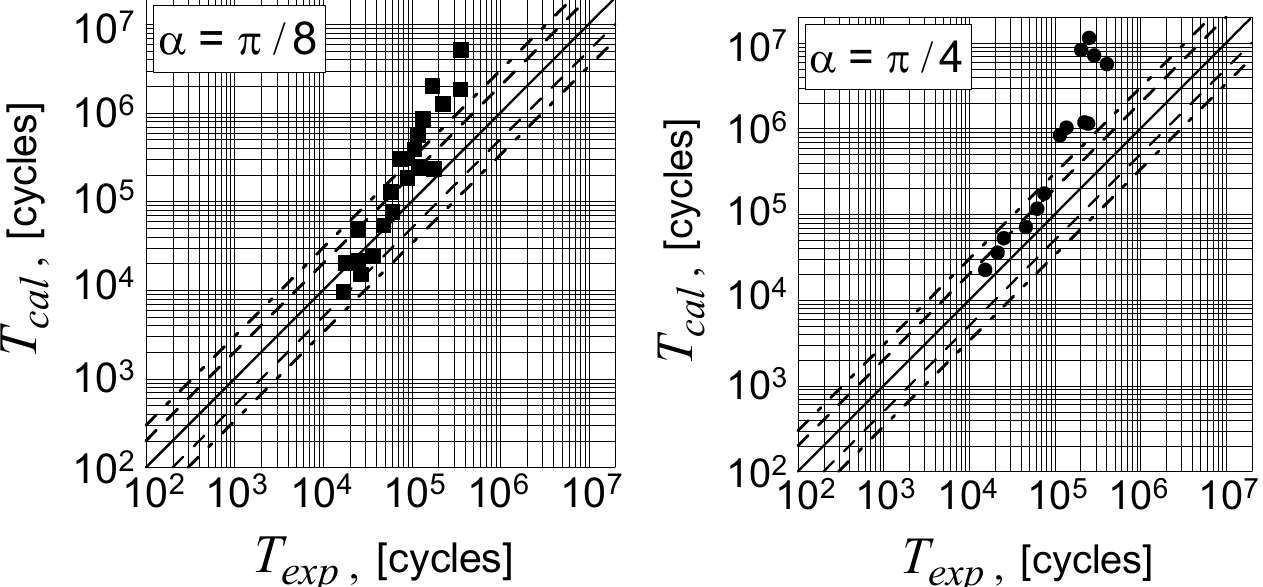
Figure 3: Comparison between experimental and theoretical fatigue lives ( / 4  